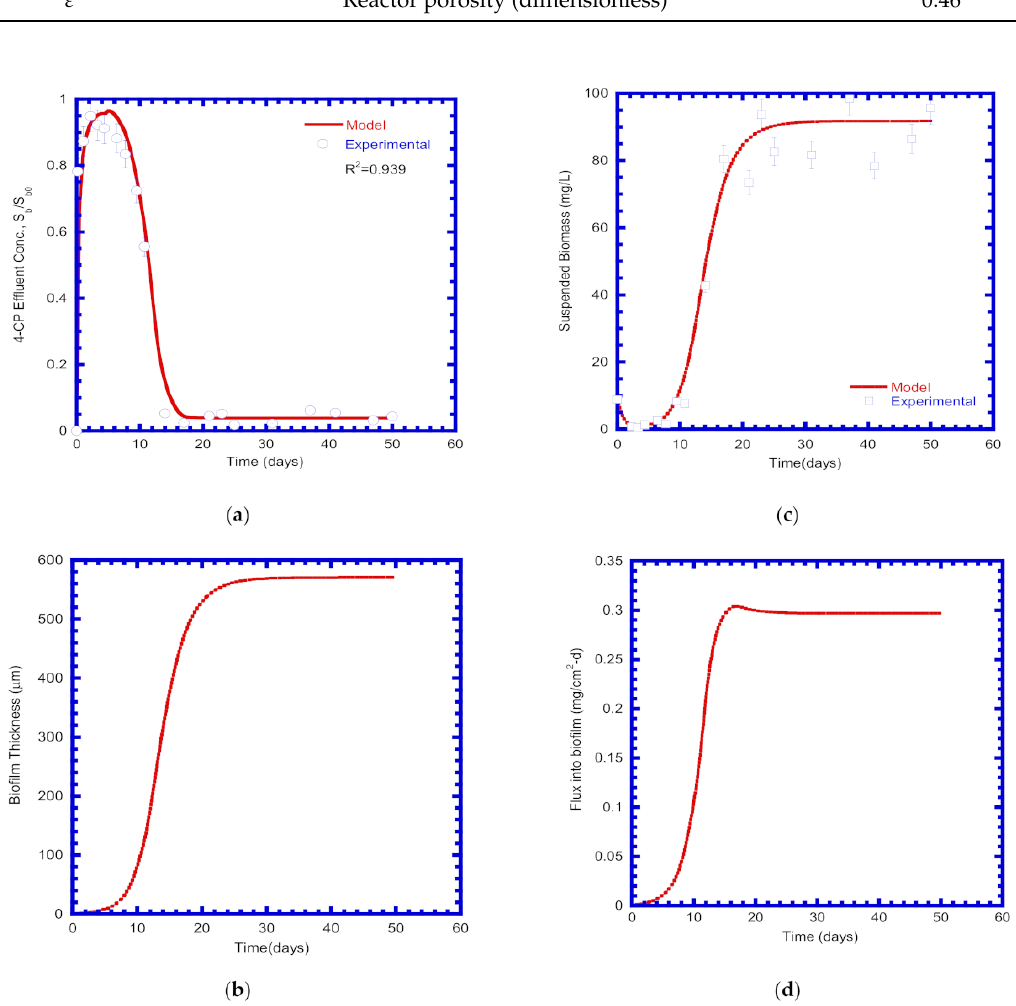
Figure 6. Comparison of experimental results and model prediction: ( a ) 4-CP effluent, ( b ) biofilm growth, ( c ) suspended biomass growth and ( d ) Flux diffused into